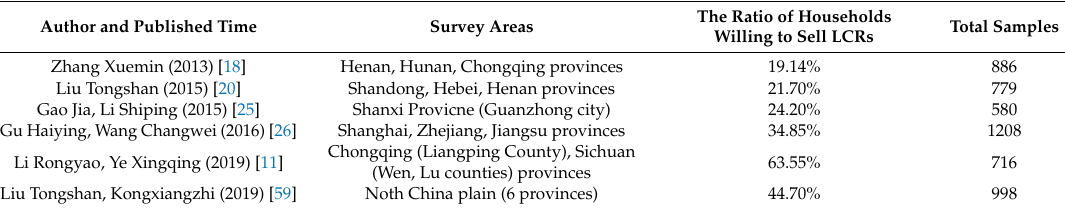
Table 6. The ratio of households willing to sell